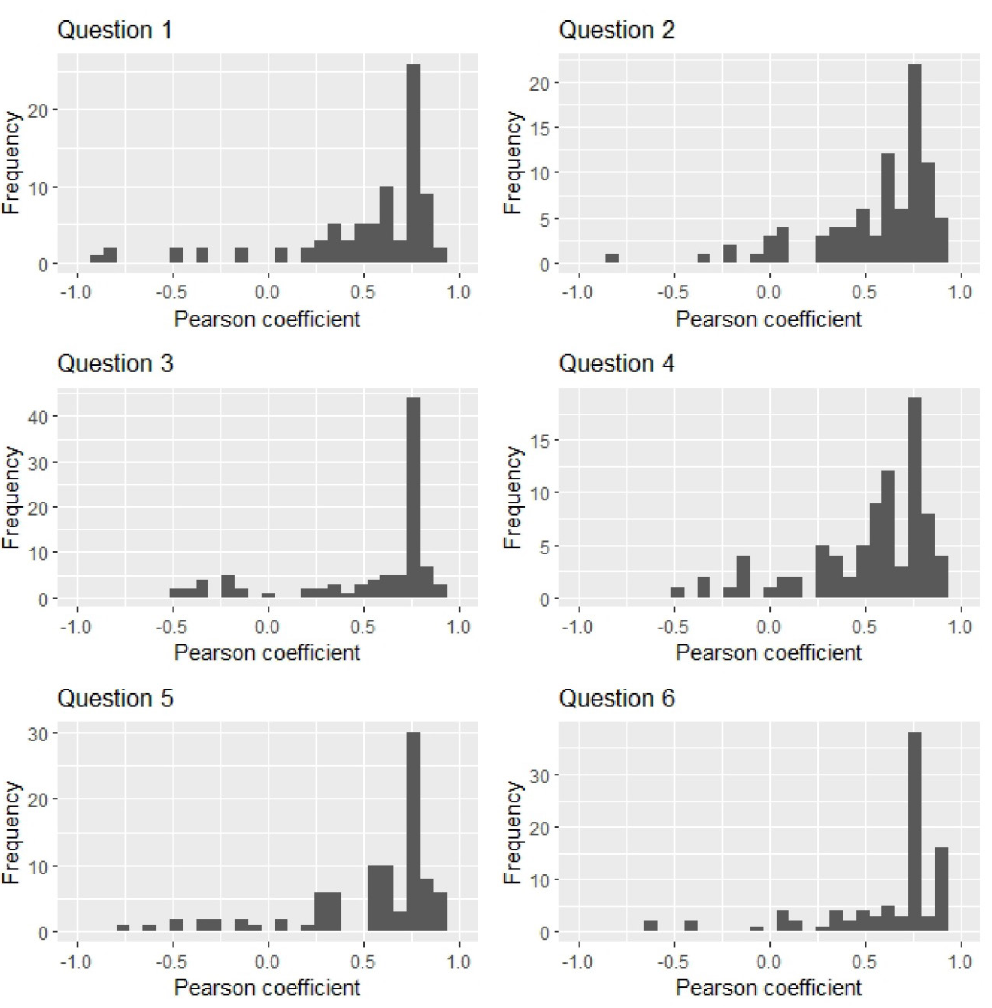
Figure 3. Histogram of Pearson correlation coefficients for each question, considering the 100 people analyzed in the in-situ experiment.